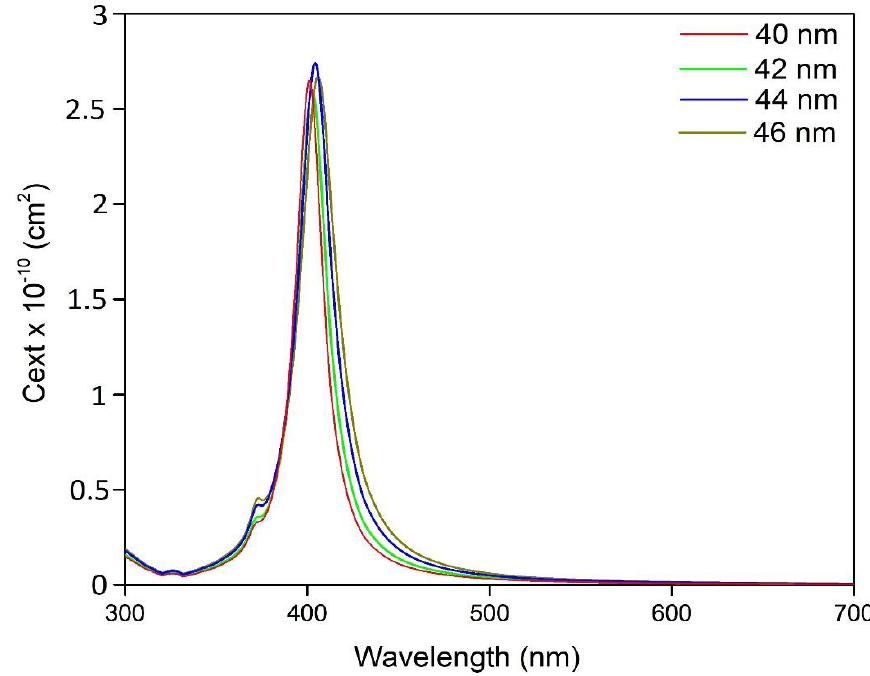
Figure 11. Extinction cross-section for AgNPs with a diameter of 40–46 nm. Figure 10. Extinction cross-section for AgNPs with a diameter of 40–46